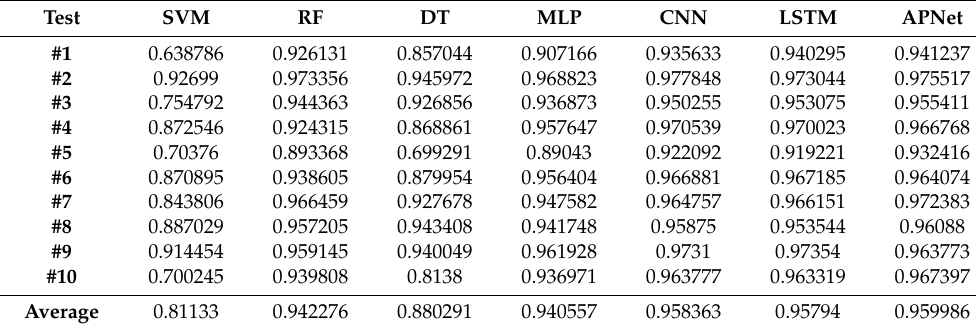
Table 3. The Pearson correlation coefficient ( n = 1415).